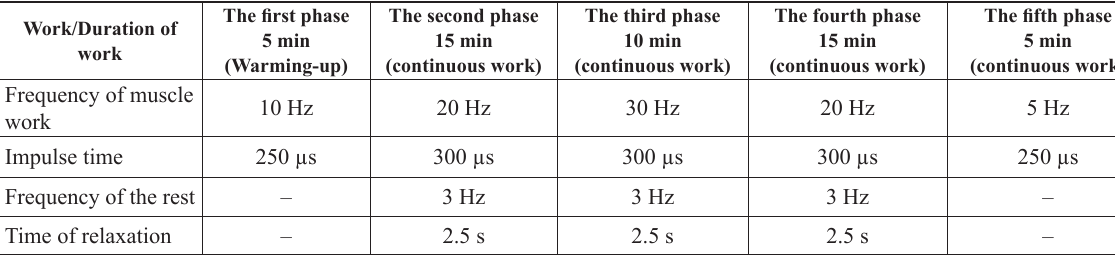
Table. The phase of the electrostimulation, frequency and duration of work Work/Duration of